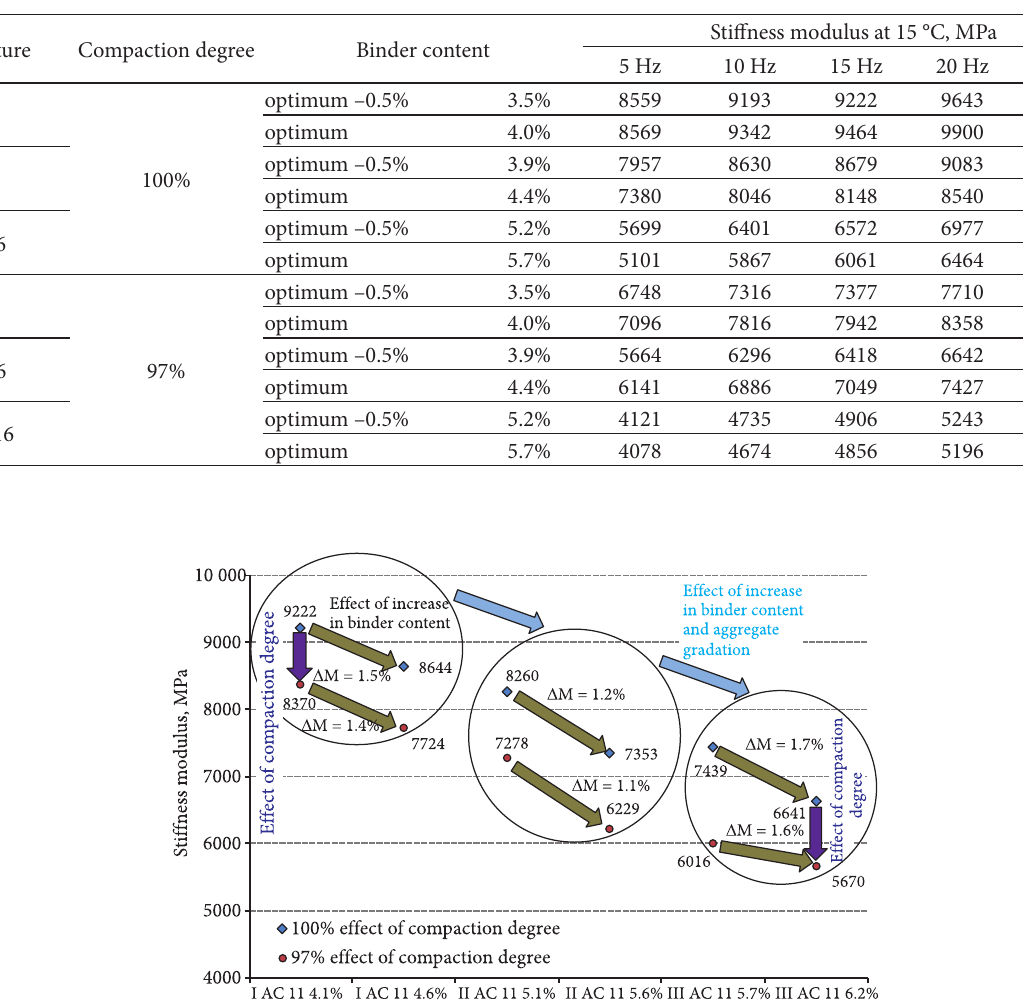
Fig. 4. Comparison of stiffness modulus of AC 11 mixtures depending on the degree of compaction (ΔM is the difference between air void content of mixture with optimal binder content and air void content of mixture with binder content reduced by